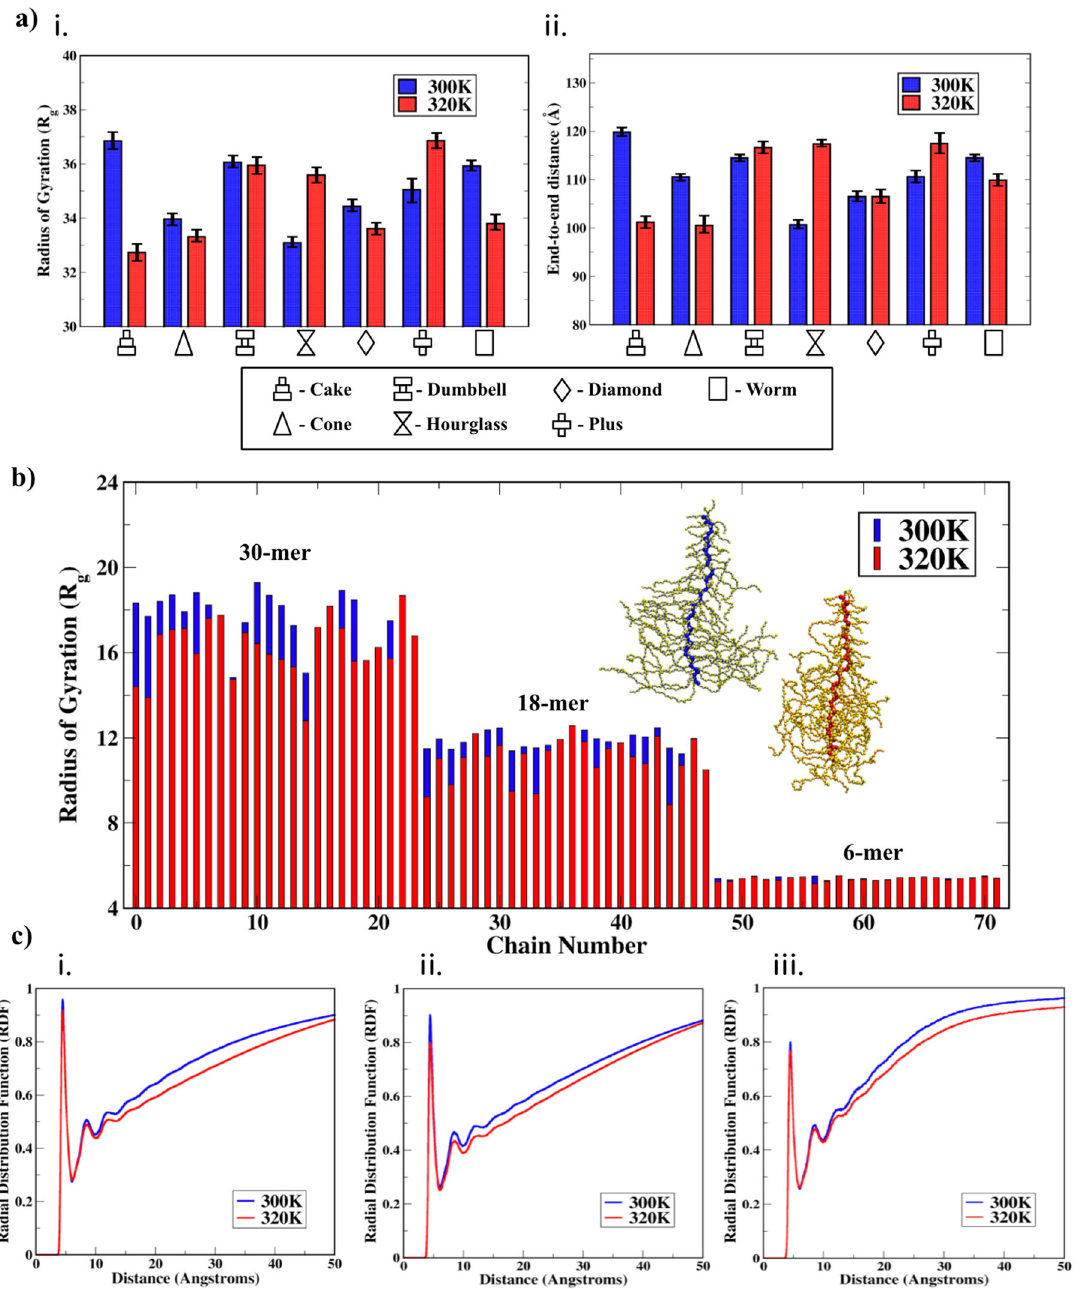
Fig. 3 Con fi gurational and solvation analysis of individual polymer chains. a Mean values of (i) backbone R g and (ii) backbone end-to-end distance for all BBPs. Legend available below the plots. b Mean R g value for each PNIPAM side chain of the cake-like BBP calculated for the last 150 ns of the simulation run. Side chain lengths are provided in the plot along with the fi nal BBP snapshots below and above LCST. The snapshots follow the scheme mentioned in Fig. 1. c Radial Distribution Function (RDF) pro fi les between water and (i) 30-mer, (ii) 18-mer and (iii) 6-mer long side chains. 300 K data is presented in blue, and 320 K data is presented in